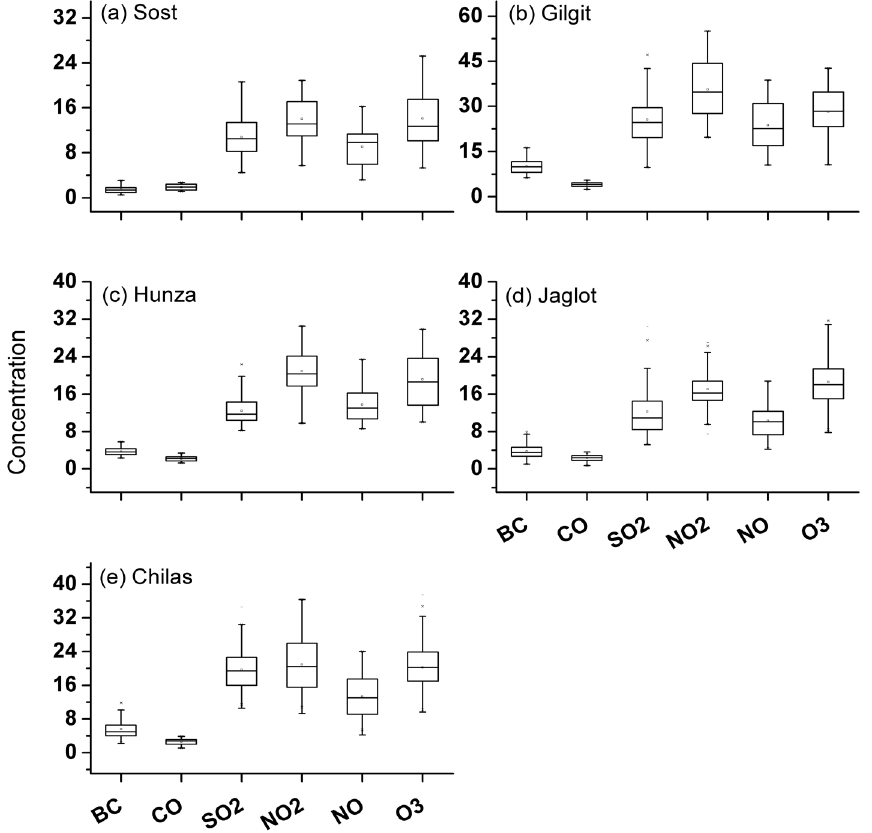
Figure 2. Variation in concentration ranges of BC ( µ g/m 3 ), CO (mg/m 3 ), SO 2 , NO, NO 2 and O 3 in µ g/m 3 at selected sites in Gilgit-Baltistan during winter, 2019.